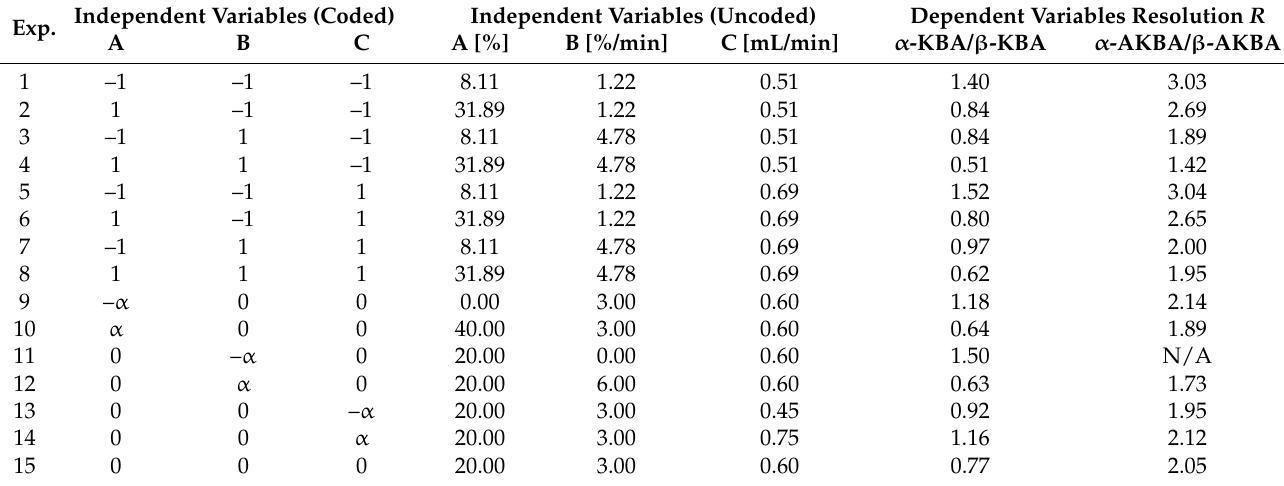
Table 2. Experimental design with level conditions for three independent variables A, B, and C (coded and uncoded) and the chromatographic resolutions, R , for separation of α -KBA and β -KBA as well as α -AKBA/ β -AKBA as dependent variables. The level conditions of experiment 5 enabled a successful separation of all constitutional isomers with required R ≥ 1.5. The conditions of experiment 11 were not appropriate to elute AKBA isomers from the